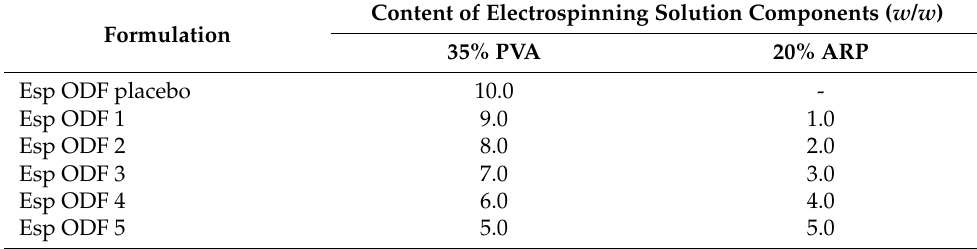
Table 1. Composition of electrospinning